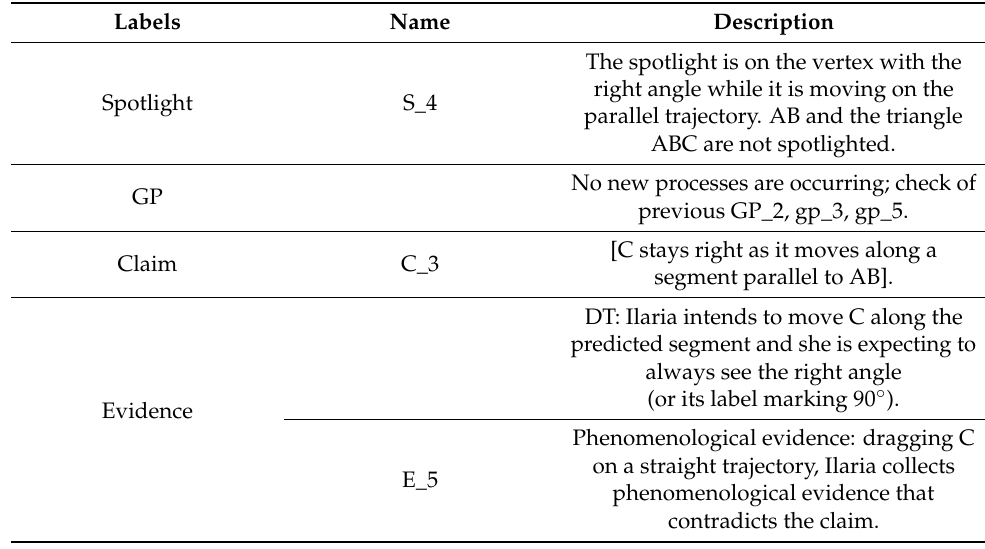
Table 6. Main elements from the analysis of Excerpt 3.